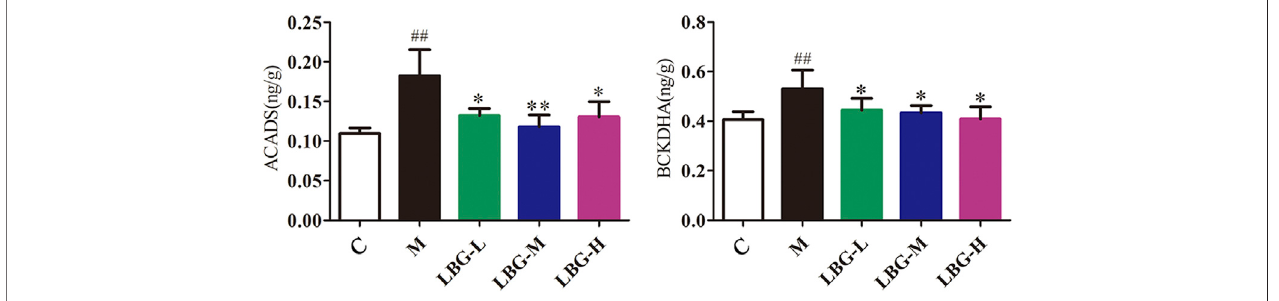
FIGURE8 | Expressionof ACADSand BCKDHA enzyme levels in mice liver tissue using ELISAanalysis.Data areexpressed asmean ± SD. ## p < 0.01 vs. Cgroup; * p < 0.05 vs. M group; ** p < 0.01 vs. M group.